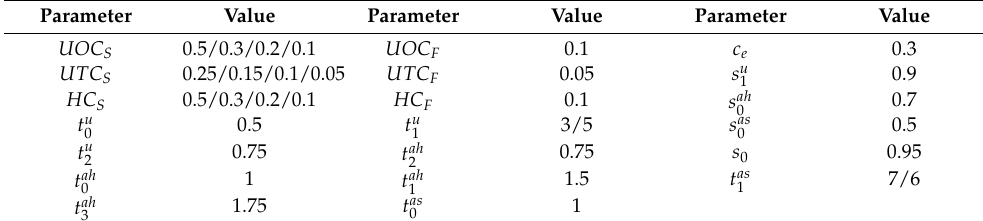
Table 6. Parameter settings.